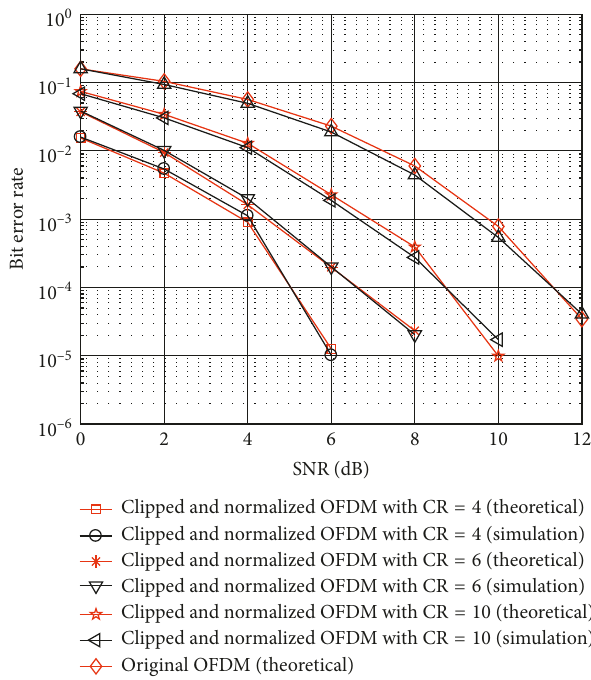
Figure 5: BER performance comparison for different clipped and normalized OFDM by simulation and theoretical methods over the AWGN channel.